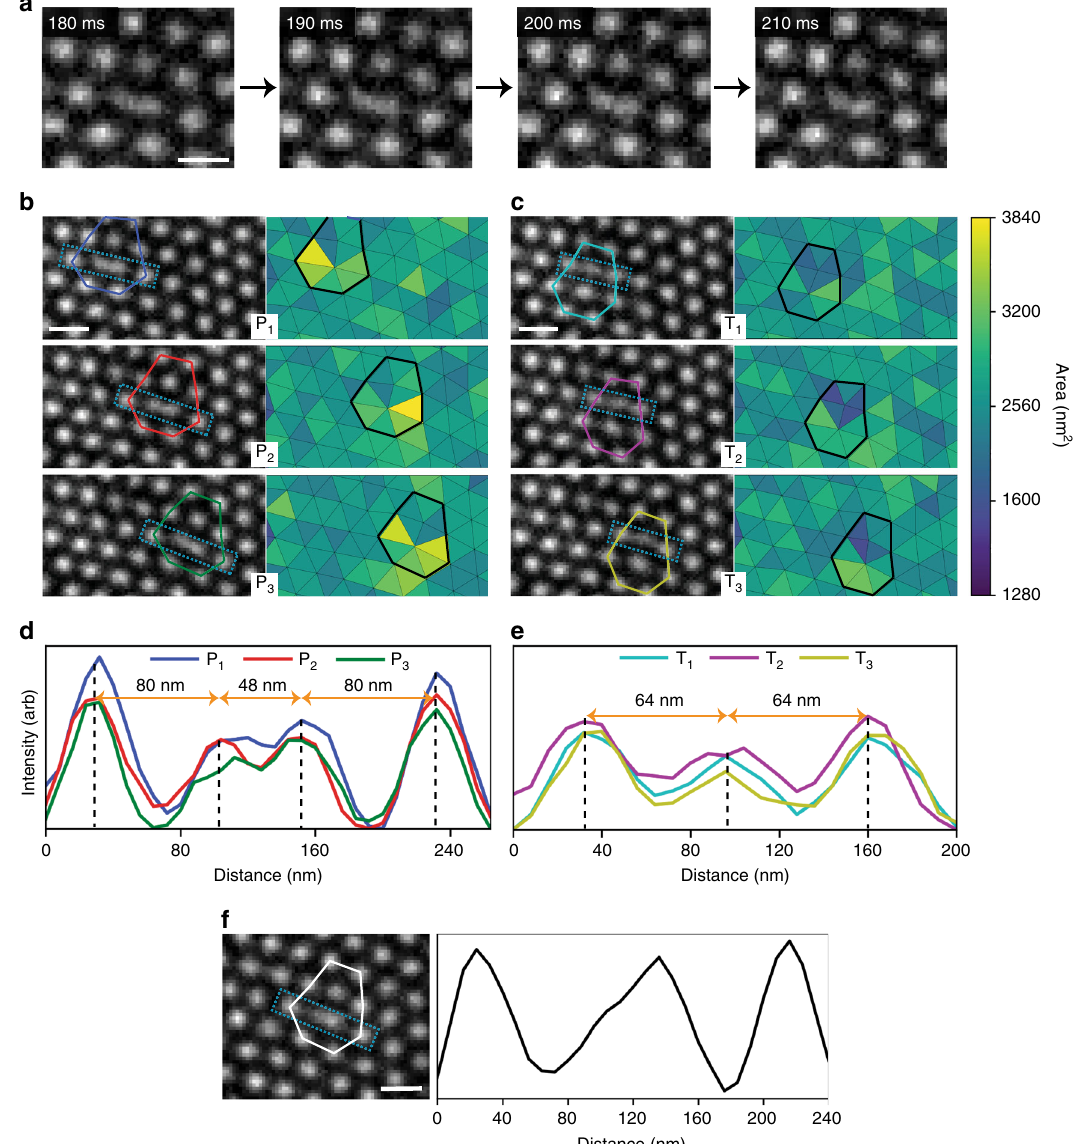
Fig. 2 Spatial analysis of the six observed con fi gurational states. a Successive frames showing the variation in structure of the SkCoH in the P 1 state with the time of each frame given in the top left of each image. Scale bar, 100 nm. b , c Summed intensity images of each observed state with coloured outlines (same colour key introduced in Fig. 1) around the 5 – 7 defects (left) and their Delaunay triangulation calculated from the skyrmion geometric centre of mass (right). The colour bar indicates the area of the triangles in nm 2 . Scale bars, 100 nm. d , e Integrated line-pro fi le plots of the P x and T x states, respectively, measured across the regions shown in b , c , (dashed rectangles). The two outermost peaks are associated with skyrmions of regular sixfold coordination. The double inner peak in d demonstrates the dumbbell-like structure of each of the SkCoH in the P x states. f Summed intensity image and integrated line- pro fi le plot across a stationary (under observation) SkCoH, for comparison. This stable 5 – 7 defect is located further down the SkX boundary, just below the right black arrow in Fig. 1a. Scale bar, 100